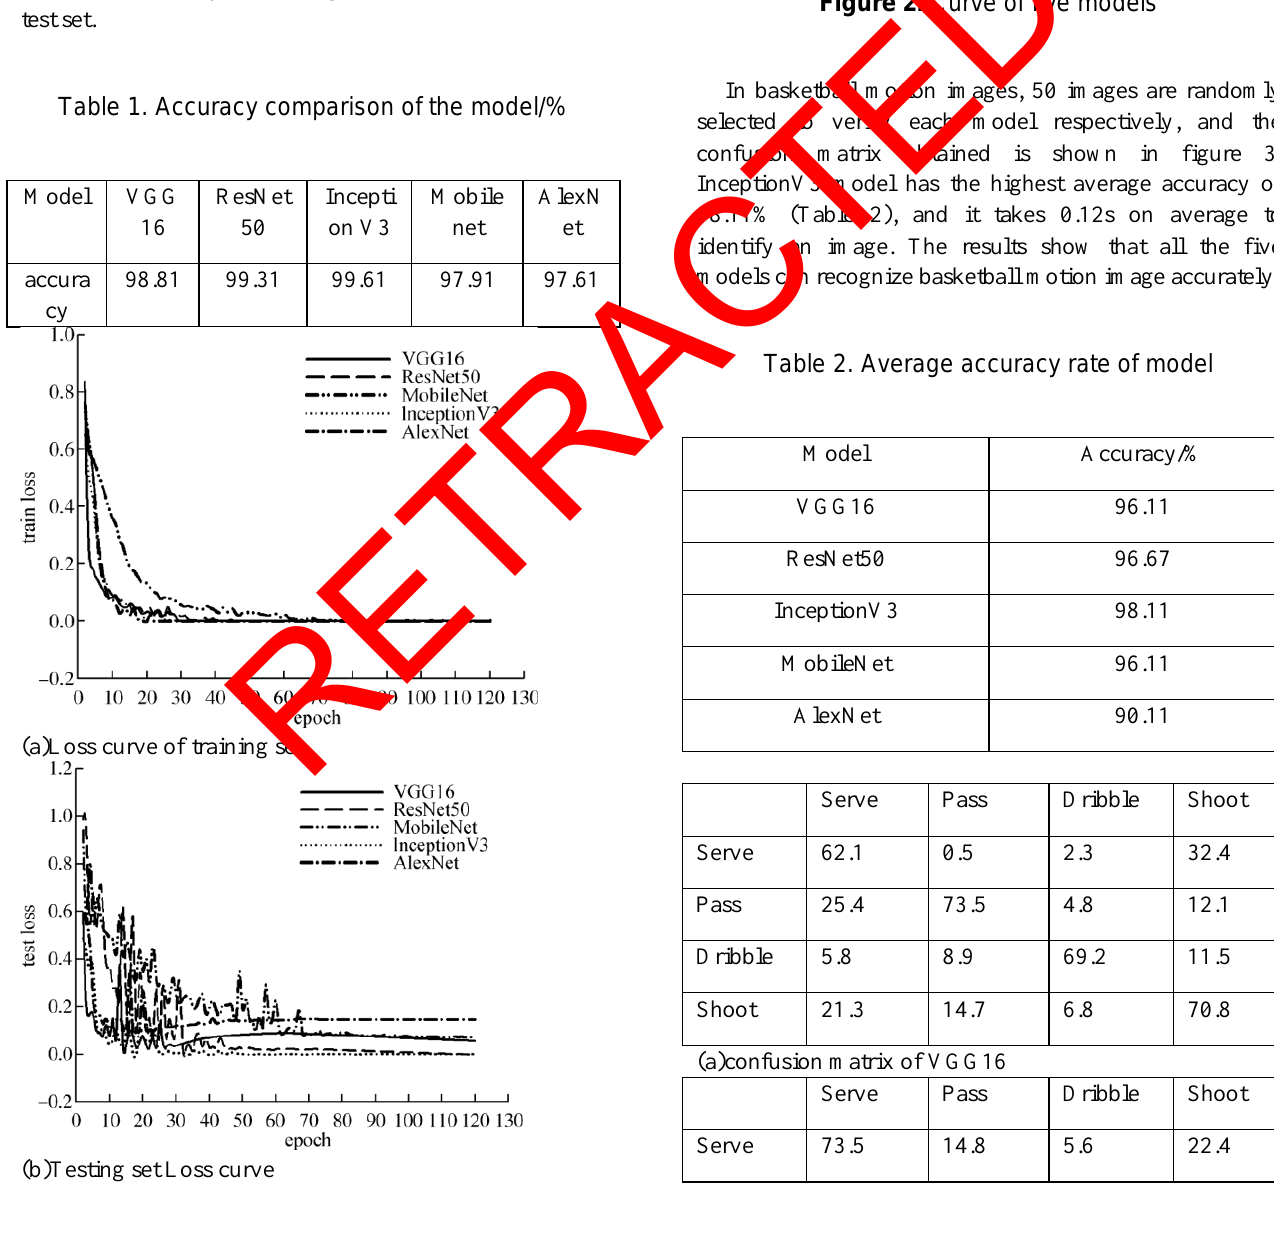
Figure 2. Curve of five models